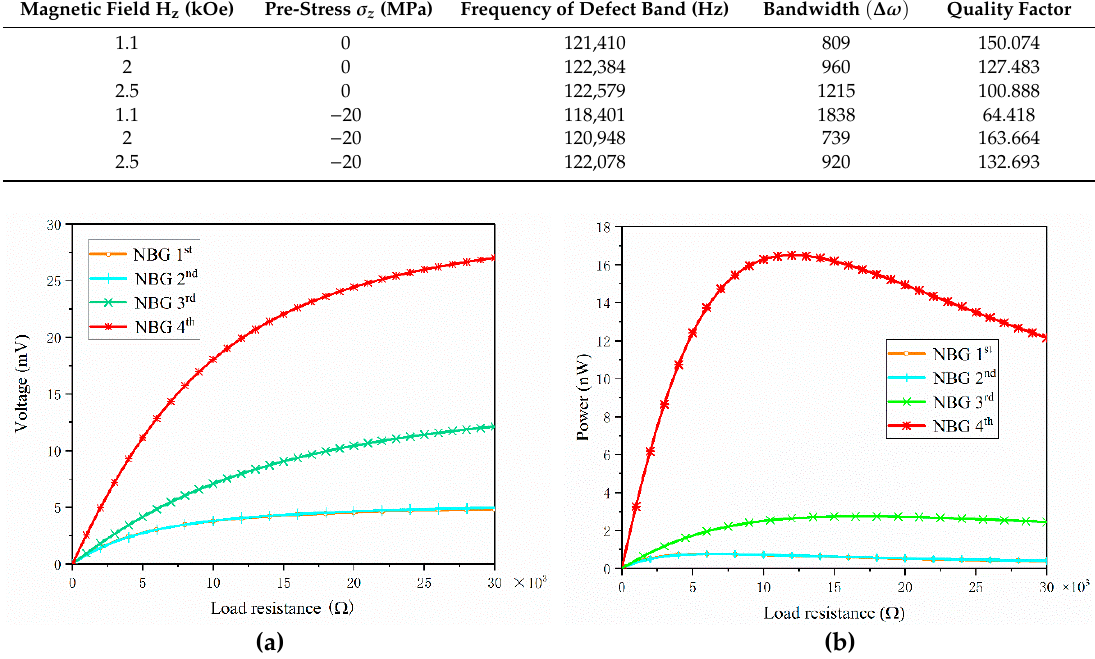
Figure 10. The output voltage ( a ) and power ( b ) versus the load resistance at the frequencies of the defect bands in the NBG at σ z = 0 MPa, H z = 1 kOe.